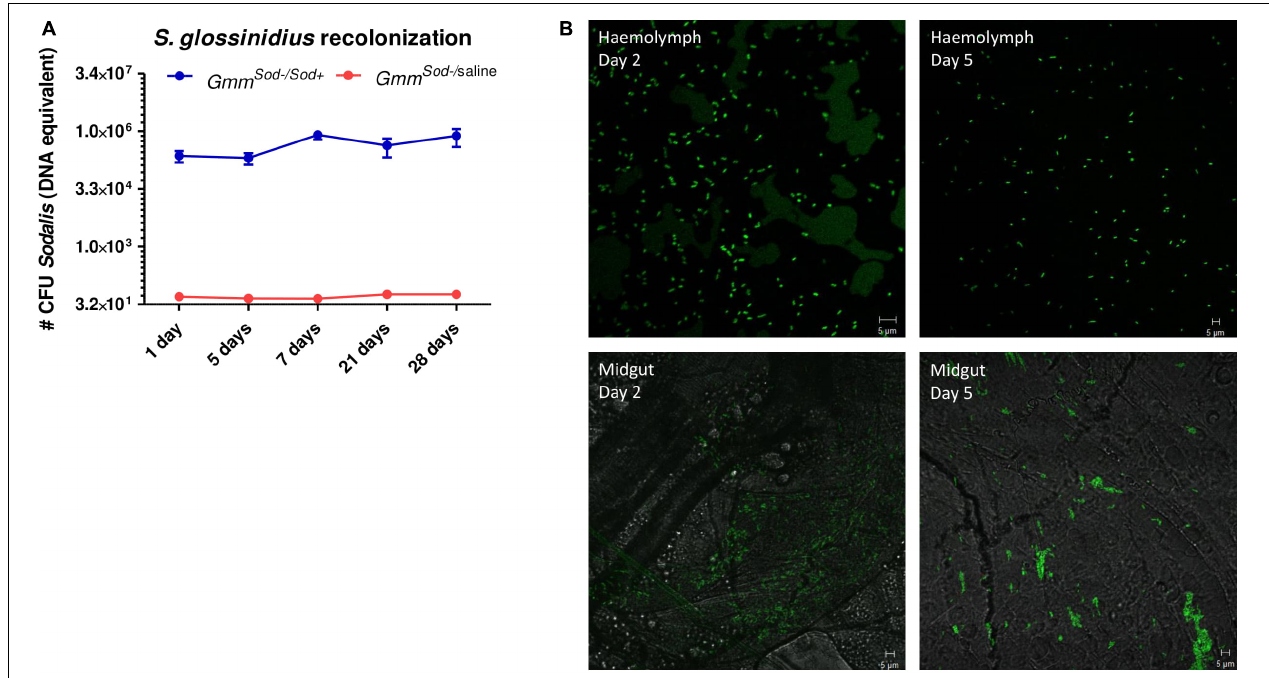
FIGURE 9 | Sodalis glossinidius recolonization in the tsetse fly assessed after exposing S. glossinidius -free flies to 10 6 CFU S. glossinidius on day 8 post-eclosion via intrathoracic microinjection and per os ( Gmm Sod − / Sod + ). (A) Monitoring of the S. glossinidius density using a standard curve-based S. glossinidius -specific qPCR assay on DNA isolated from the fly abdomen at multiple time points after exposure; N = 8 independent replicates per time point. As a control, the S. glossinidius density was obtained in flies injected with sterile saline ( Gmm Sod − / saline ); N = 3 independent replicates per time point. Values show the bacterial density in each abdomen and are represented as the mean with the standard deviation. The number S. glossinidius CFU is represented in log-scale on the y-axis. (B) Visualization of S. glossinidius bacteria in the tsetse fly hemolymph and midgut two and five days after exposure.